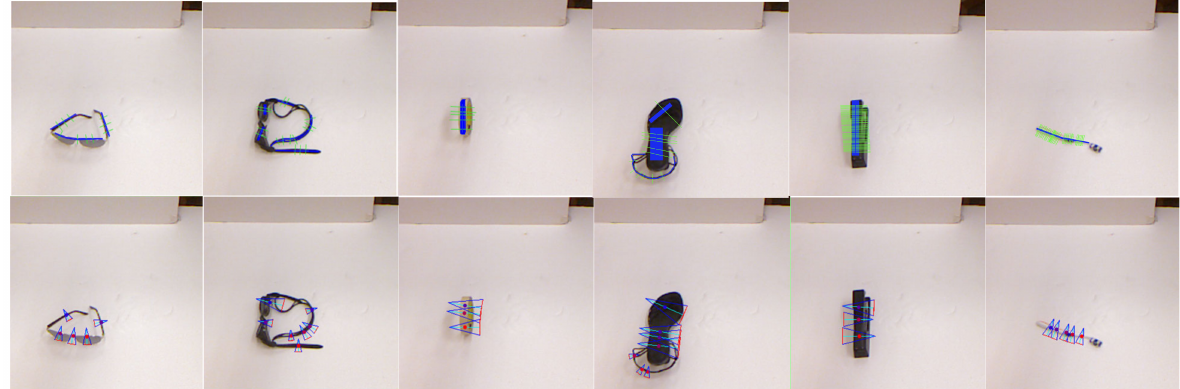
Figure 7. Grasp detections in the Cornell Grasp dataset. The first column is the label image and the second column is the predicted grasp strategy.